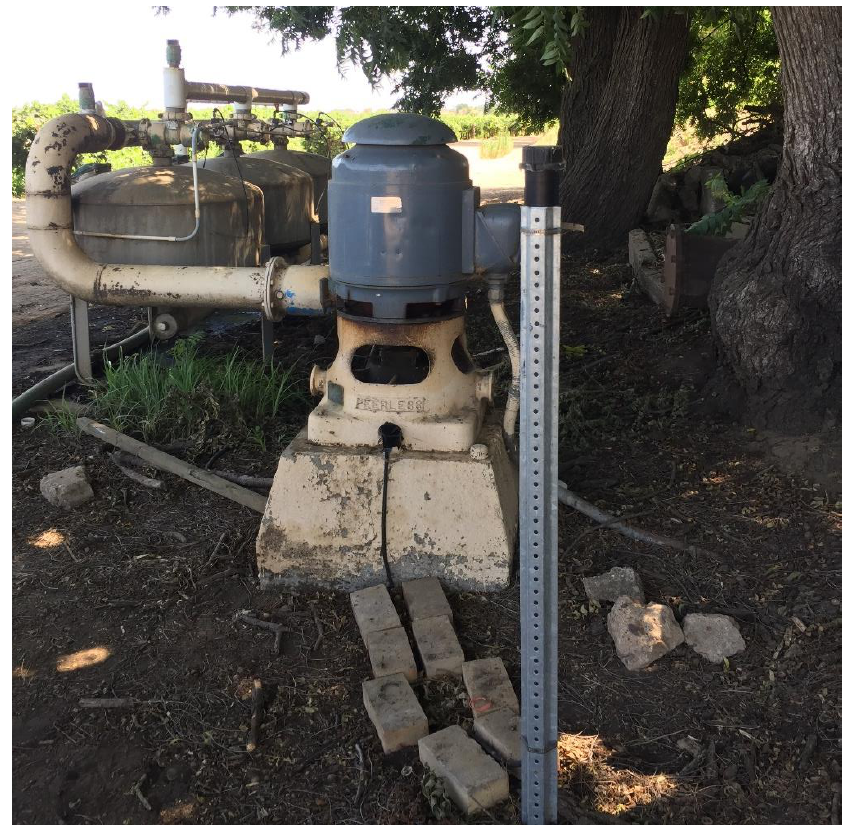
Figure A2. Installation of a telemetry unit for a pumping well.